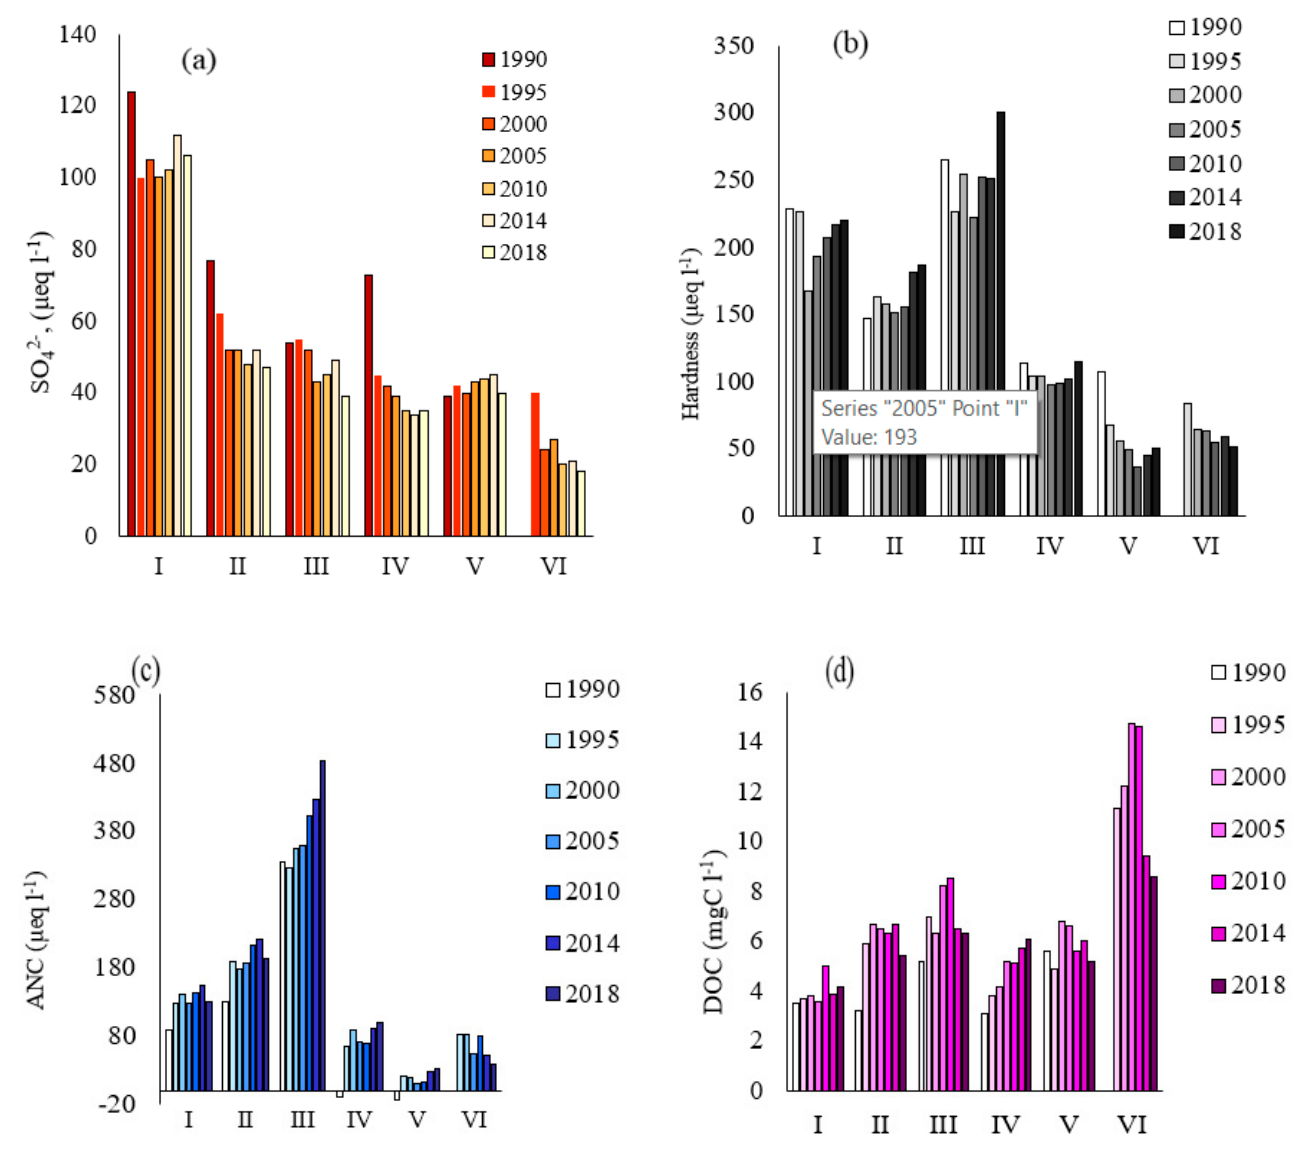
Figure 4. Distribution of water chemistry parameters of the water bodies for a 28-year period (1990–2018) in various subregions of the Kola North: ( a ) SO 4 * ( μ eq L -1 ), ( b ) Hardness ( μ eq L -1 ), ( c ) ANC ( μ eq L -1 ), ( d ) DOC (mgC L -1 ); I – VI – subregions.